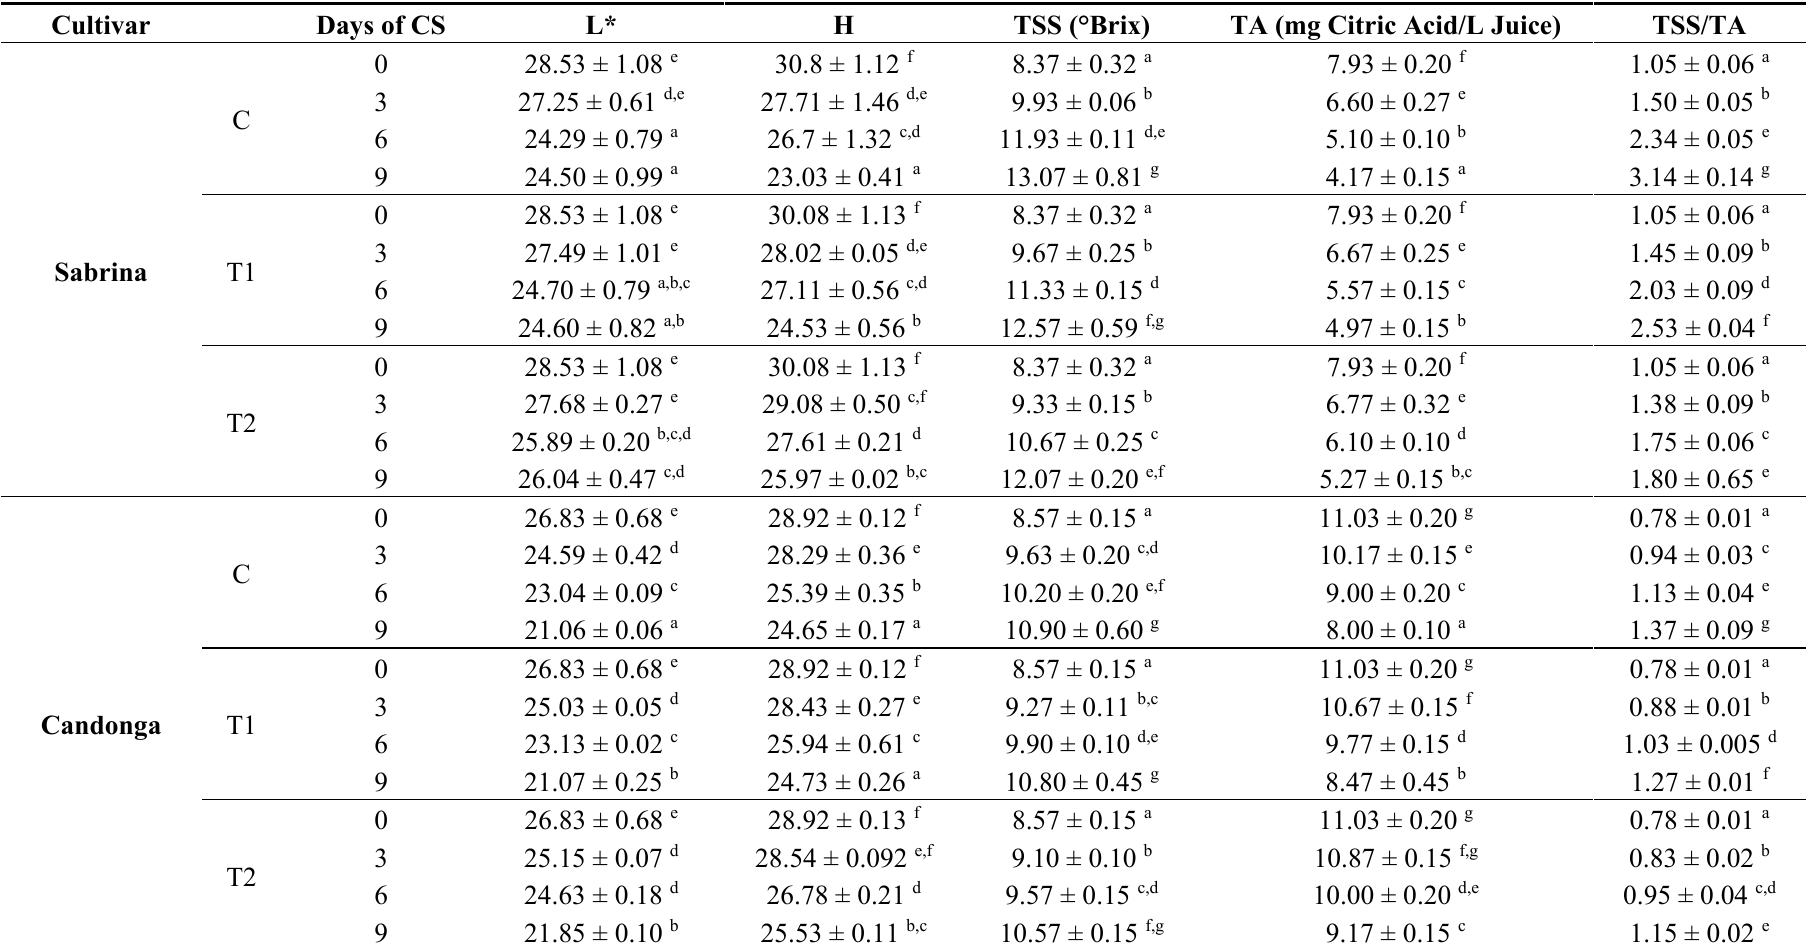
Table 1. Effect of chitosan treatments on lightness (L*), hue angle (H), soluble solid content (TSS), titratable acidity (TA) and the TSS/TA ratio of three strawberry cultivars tested as a function of cold storage (CS)